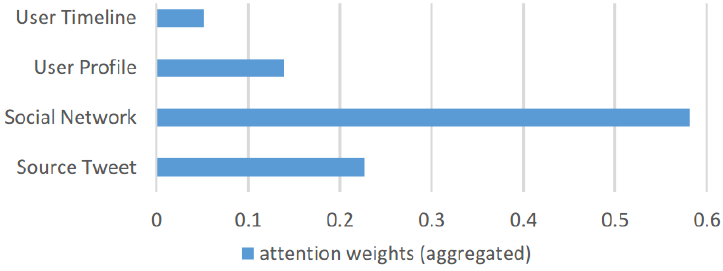
Figure 13. Feature importance for each component.